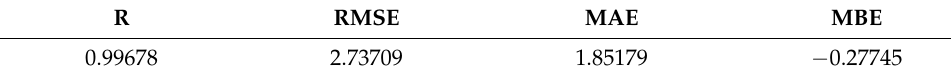
Figure 6. Error histogram of the (5-15-10-1) ANN model for the simulated datasets. 3.3. Sensitivity Analysis After the validation stage of a developed ANN model, it is necessary to gain an idea about the uncertainties associated with the relationships between the output (weight left percent) and the input parameters. In general, sensitivity analysis aims to check the effect of a small change in an input parameter on the output variable. In this work, sensitivity